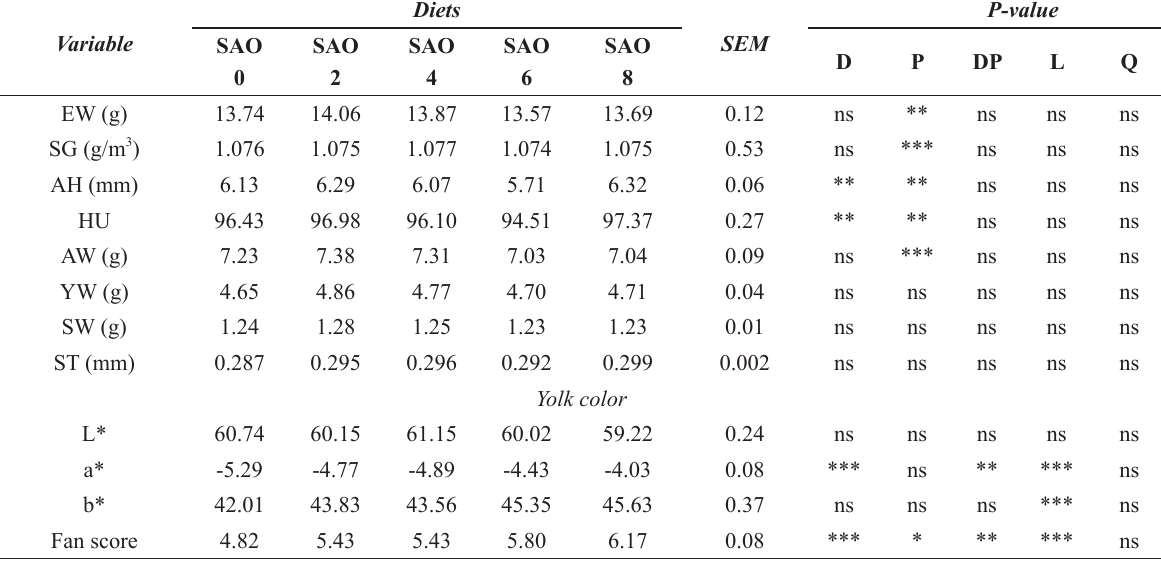
Quality of fresh eggs of quails fed with increasing levels of soybean acid oil as replacer of soybean oil in the diet.